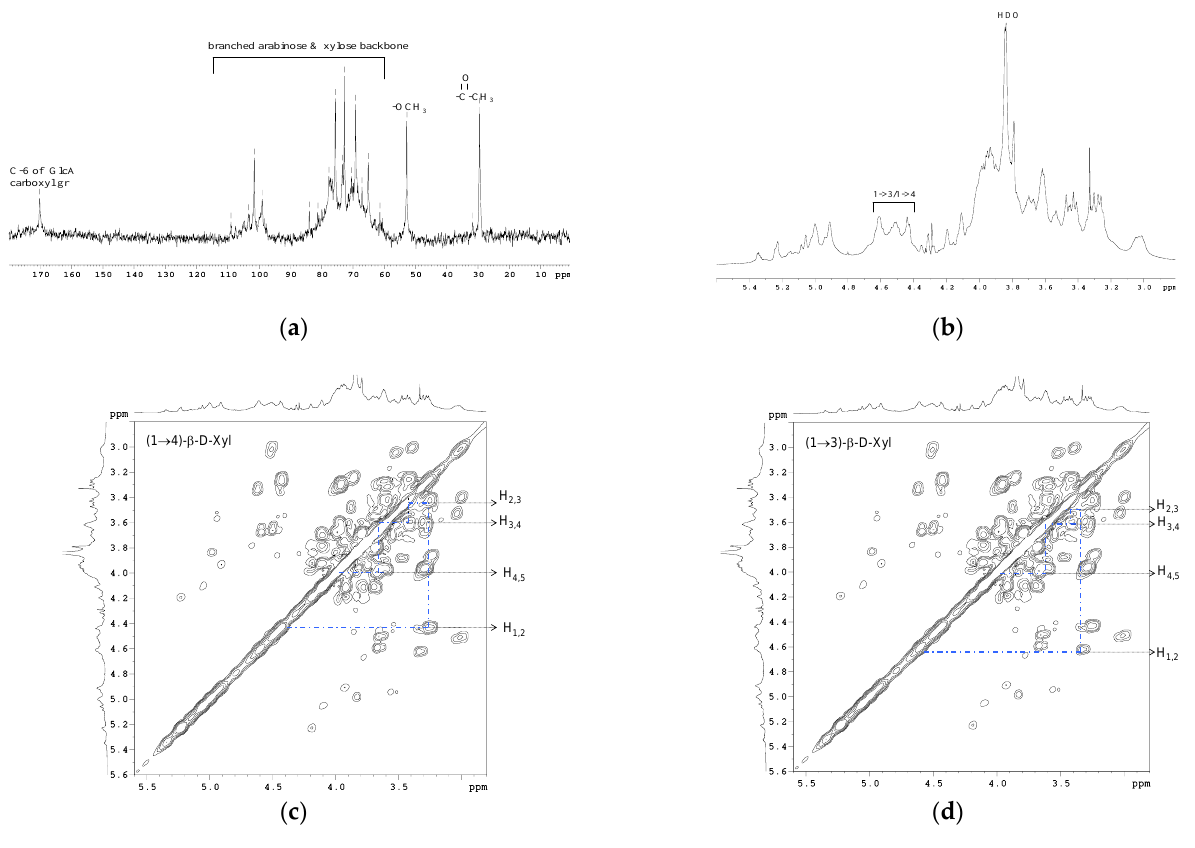
Table 2. Assignment of 1 H NMR spectrum of Yanang gum .